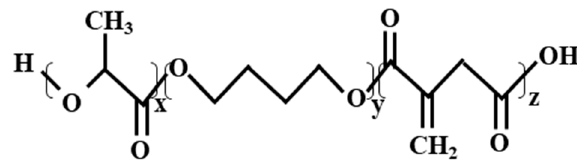
Figure 6. Poly( d , l -lactic acid-1,4-butanediol–itaconic acid) copolymer obtained from polycondensation Figure 6. Poly( D , L -lactic acid-1,4-butanediol–itaconic acid) copolymer obtained from of d , l -lactic acid, 1,4-butanediol, and polycondensation of D , L -lactic acid, 1,4-butanediol, and IA.